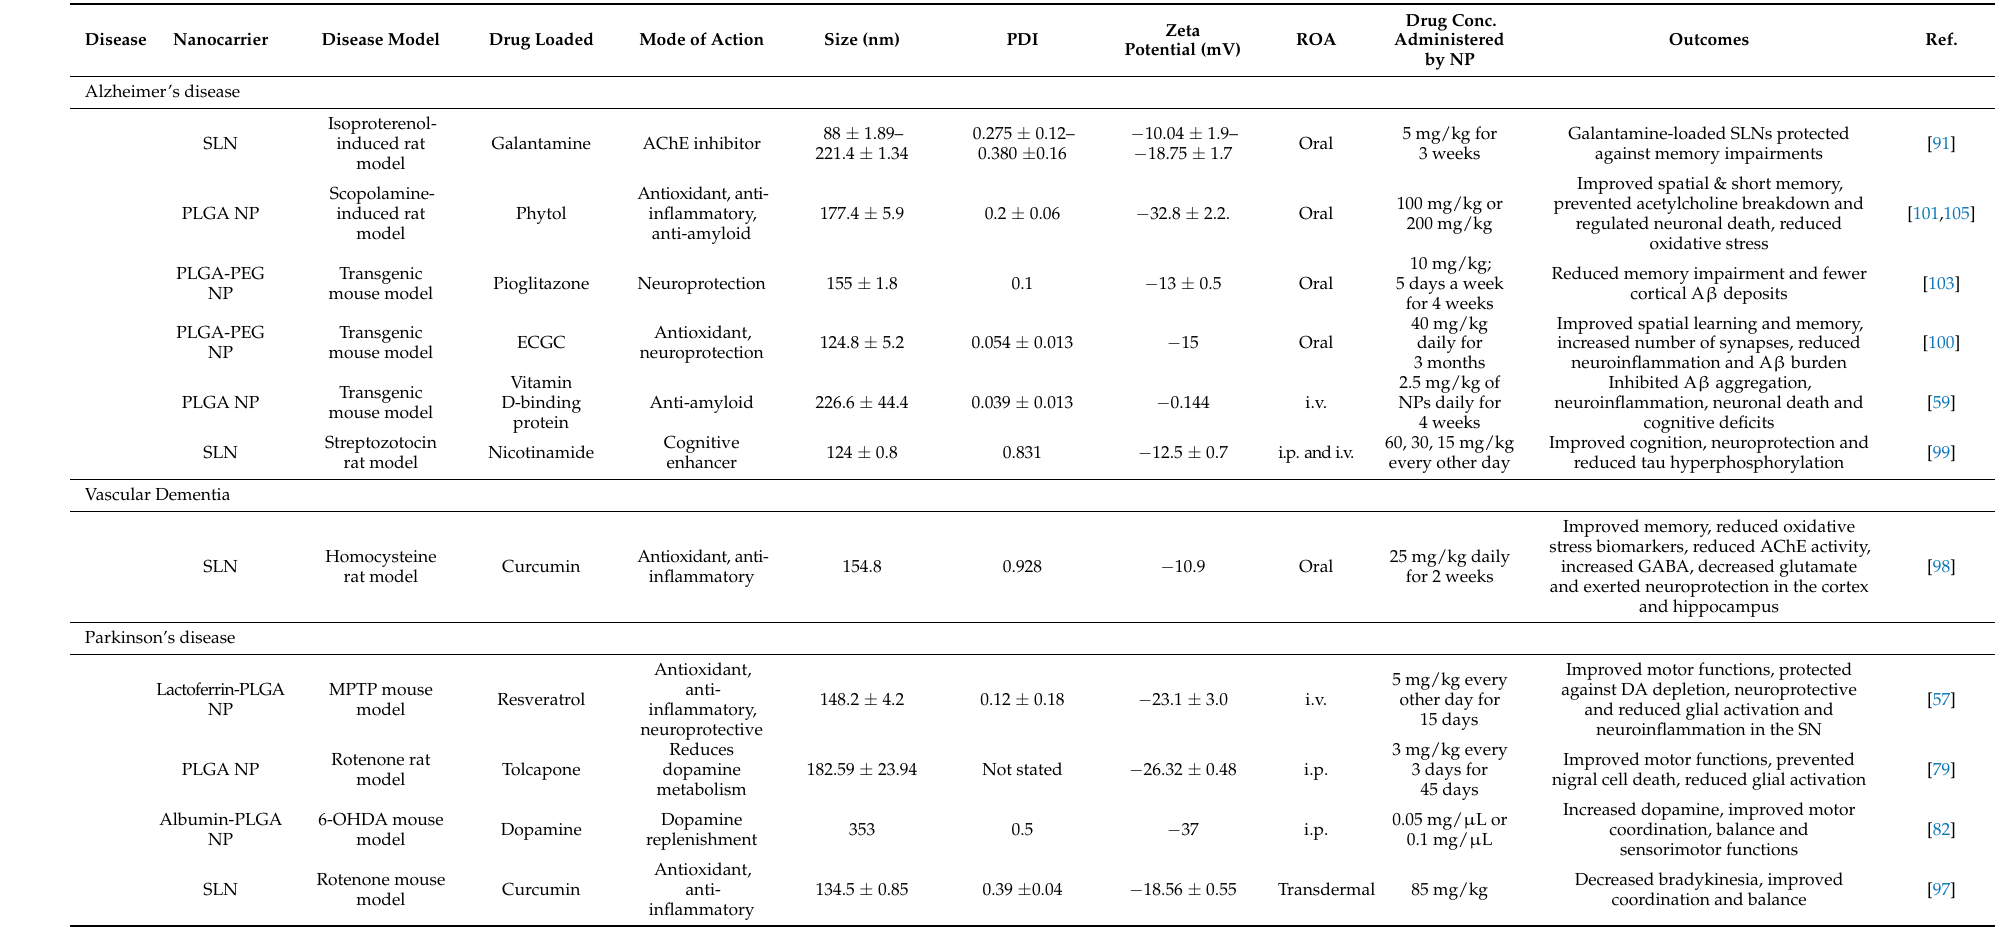
Table 1. Physicochemical properties of PLGA NPs and SLNs delivered in